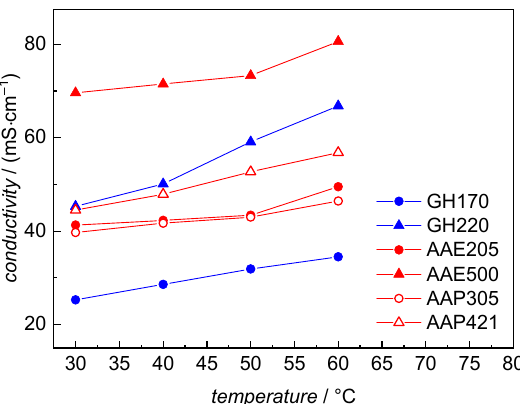
Figure 4. Conductivities for temperatures between 30 and 60 °C derived from impedance spectroscopy.